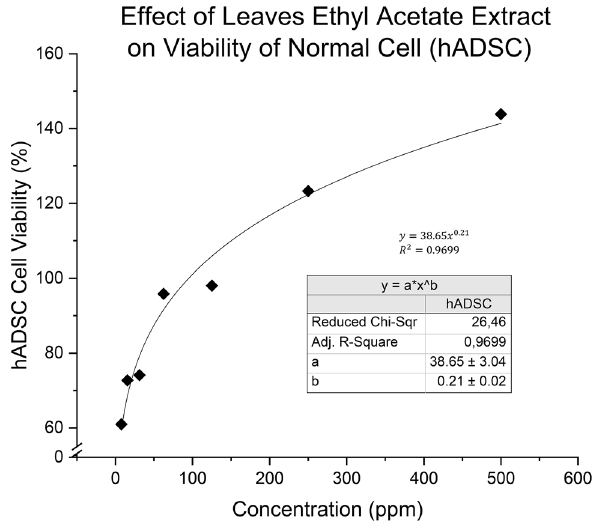
Figure 4. Effect of X. granatum towards viability of human adipose-derived stem cell (hADSC).